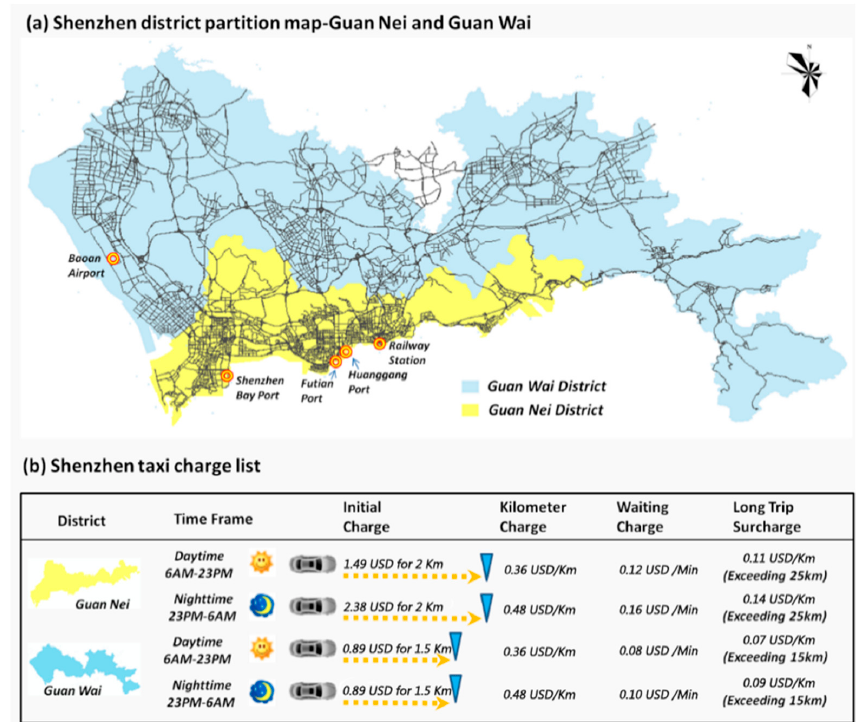
Figure 5. Shenzhen district partition and taxi charge list (the source of the geographical background is Mapbox).